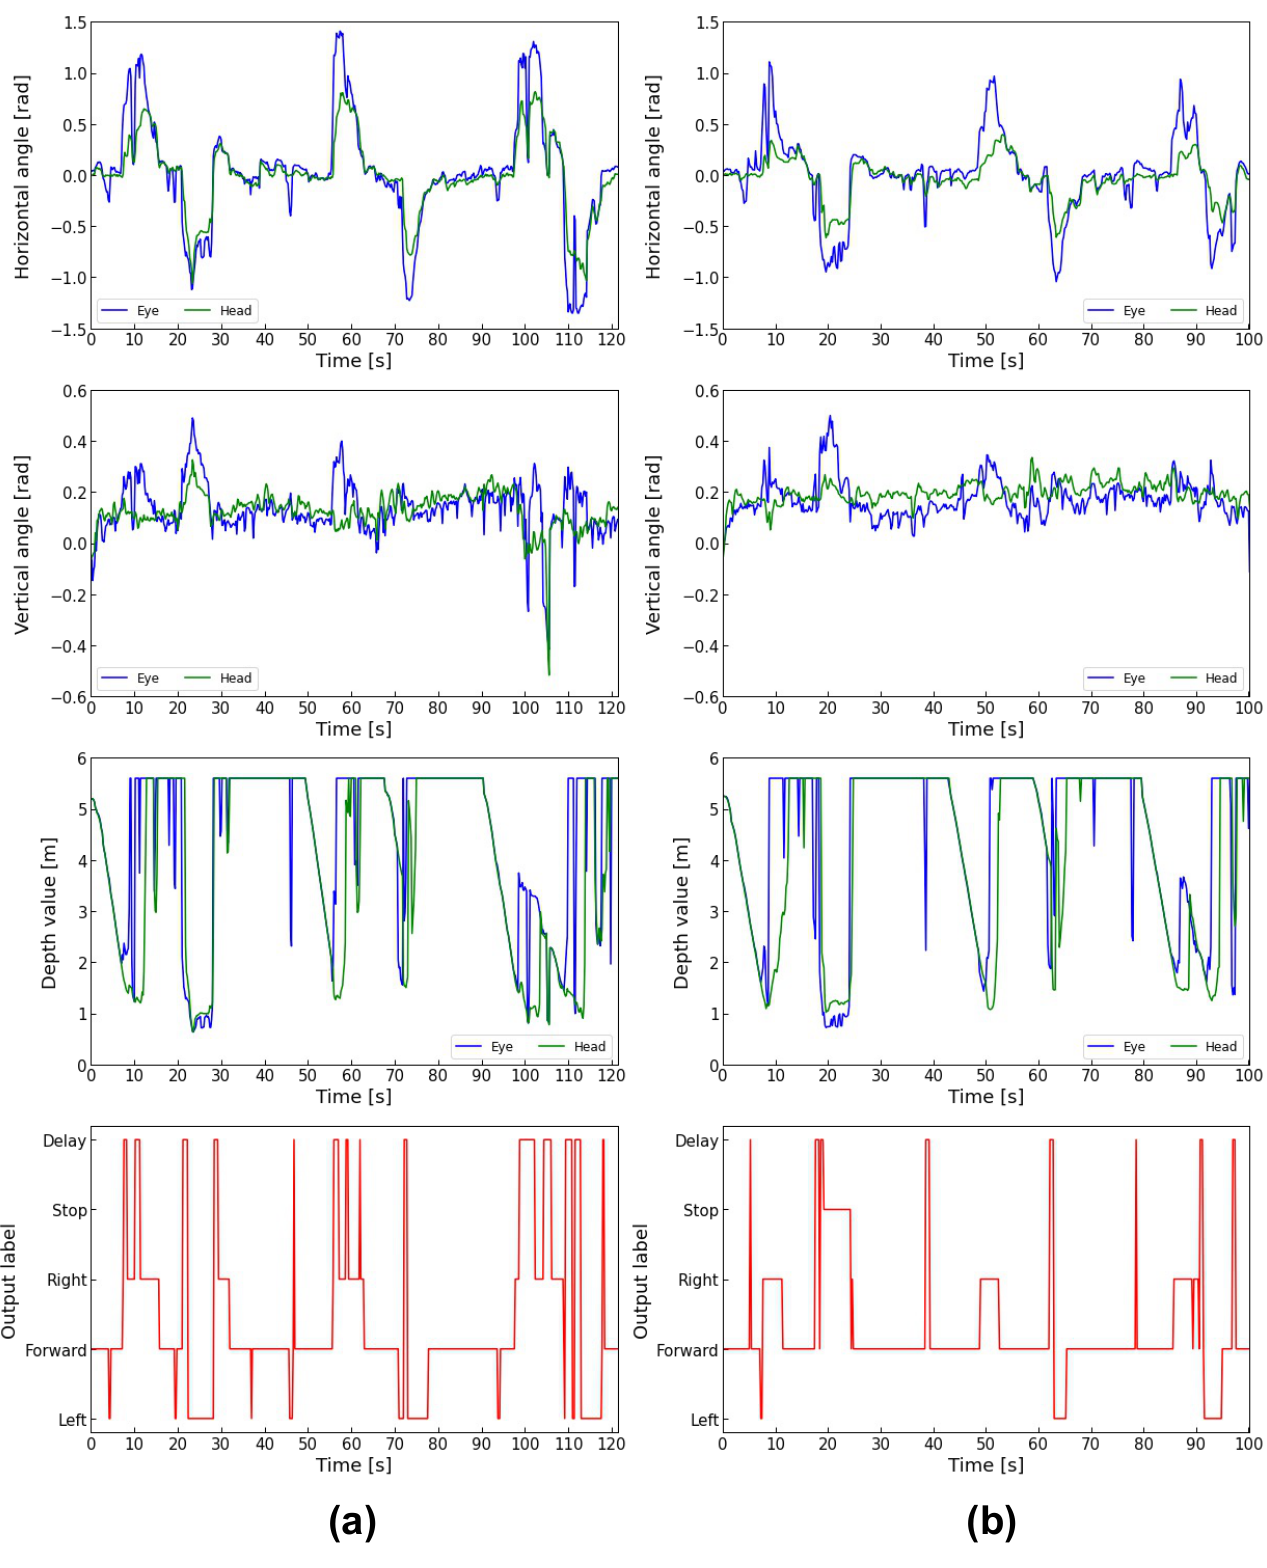
Figure 14. Comparison of Subject B’s driving data: ( a ) Driving data in the traditional method; ( b ) Driving data in the proposed